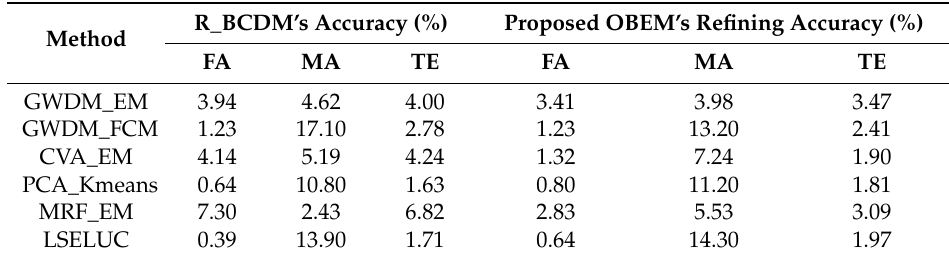
Table 7. Comparison between existing preprocessing methods and the OBEM post-processing approach for the fourth data set (Landsat images with 30 m/pixel